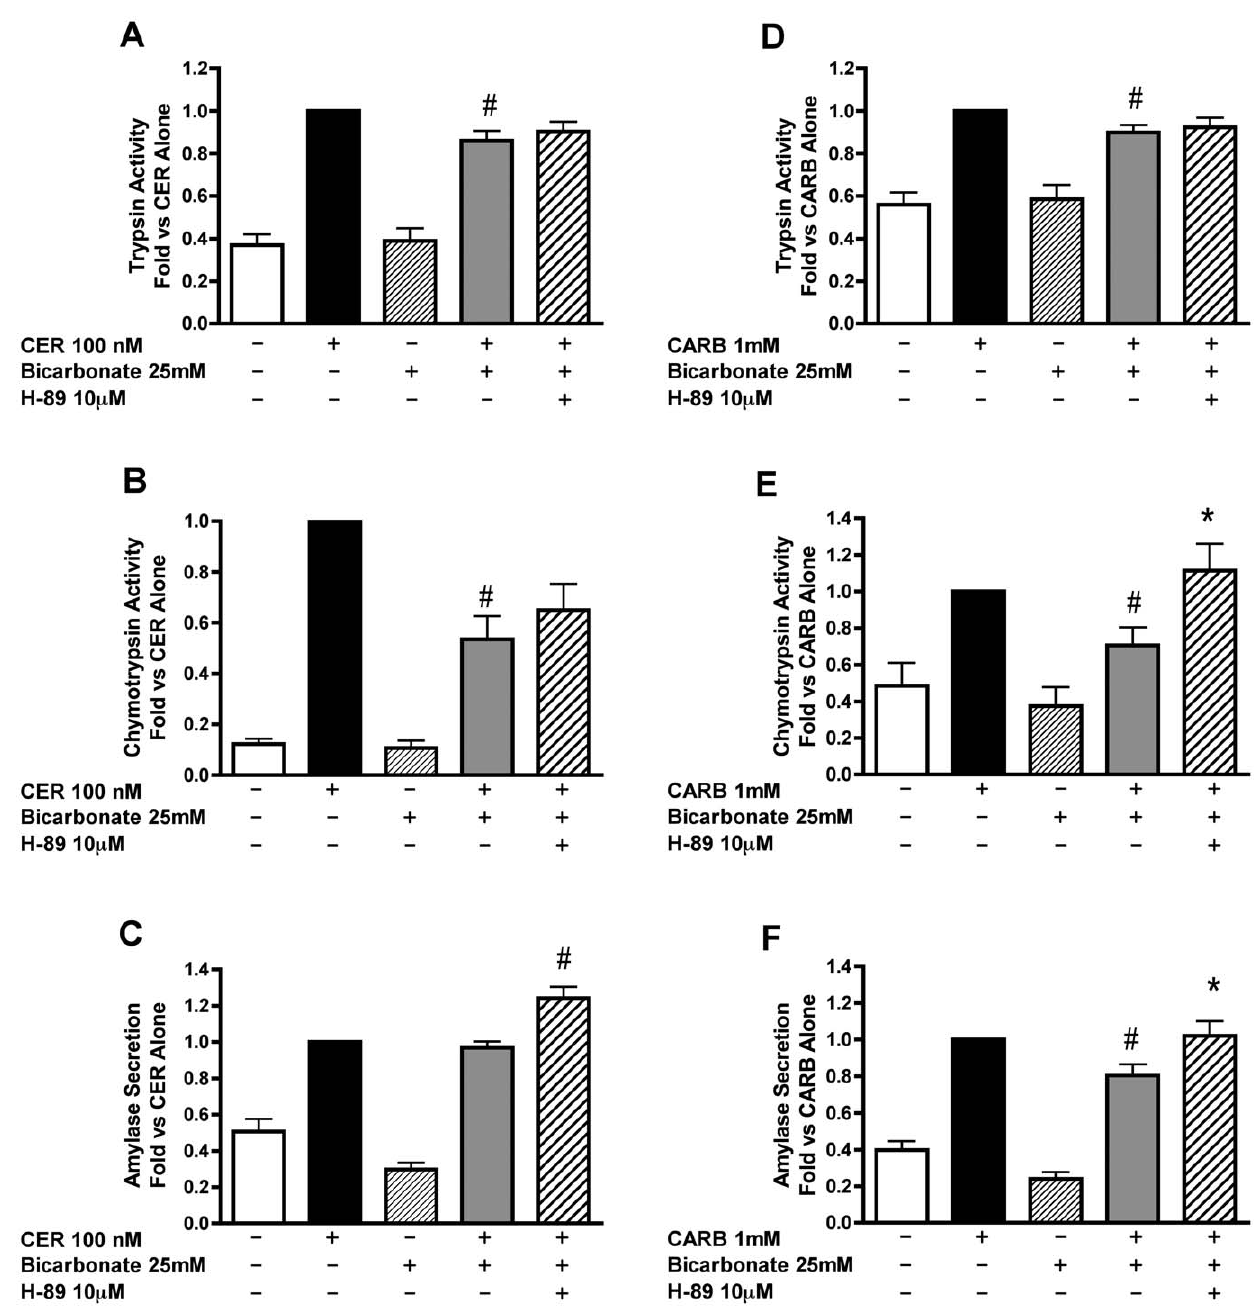
Figure 9. The effect of bicarbonate on secretagogue stimulated zymogen activation is decreased by PKA inhibition using H89. Acini were treated with or without the PKA inhibitor H89 [10 m M] for 30 min prior to changing media and replacing it with either bicarbonate [25 mM] at a constant flow of air/CO 2 (95/5%) or without the addition of bicarbonate under room air conditions. H89 was added back to the appropriate wells. Secretagogue (CER 100 nM or CARB 1 mM) was added immediately after media change to the appropriate wells and acini incubated for 1 hour. Acini were collected and assayed for trypsinogen activation (A,D), chymotrypsinogen activation (B,E) and amylase secretion (C,F). # p , 0.05 vs. corresponding secretagogue alone, *p , 0.05 vs. corresponding secretagogue/bicarbonate treatment (n $ 5).